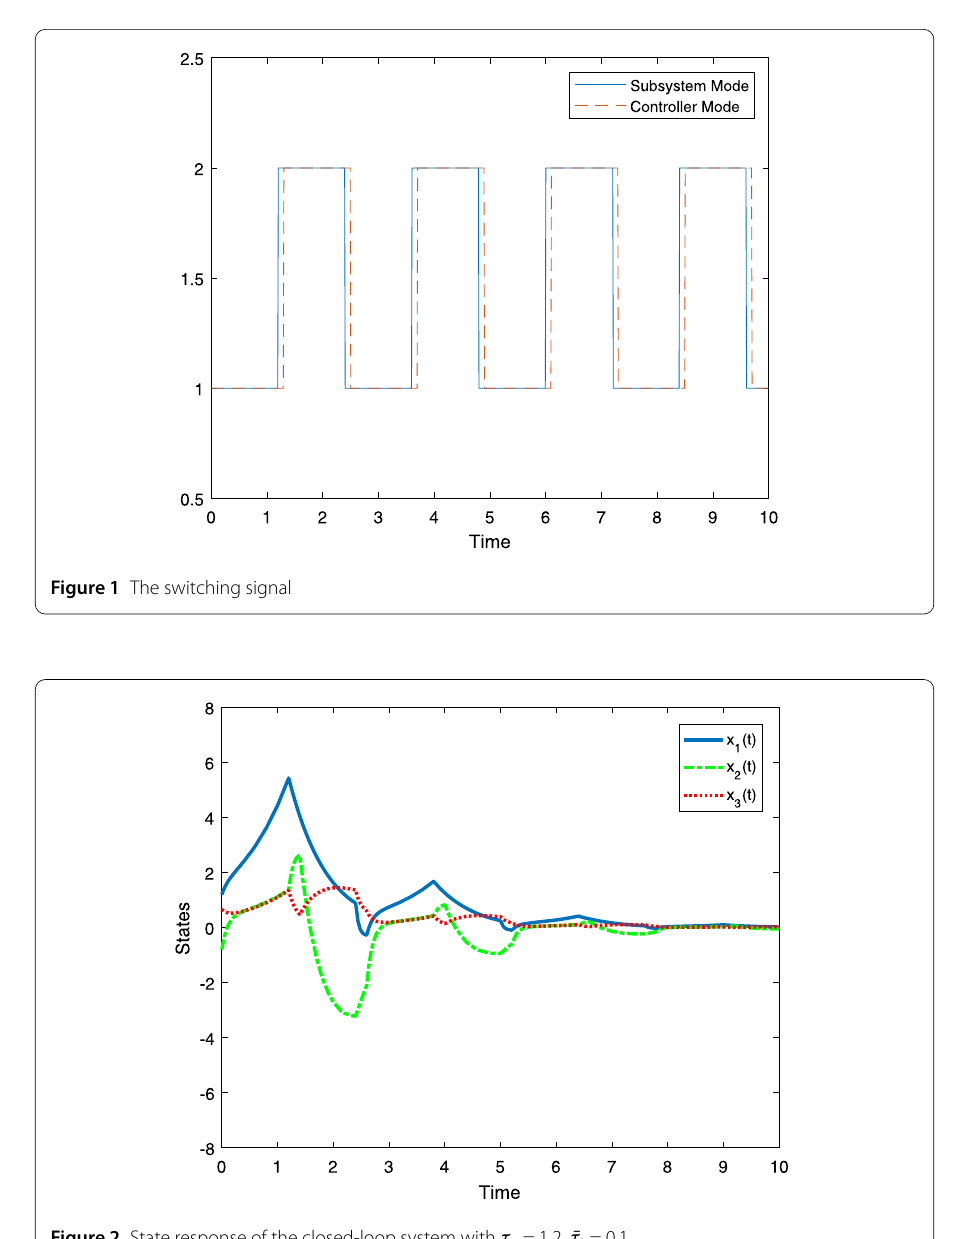
Figure 2 State response of the closed-loop system with τ a = 1.2, ¯ τ t =